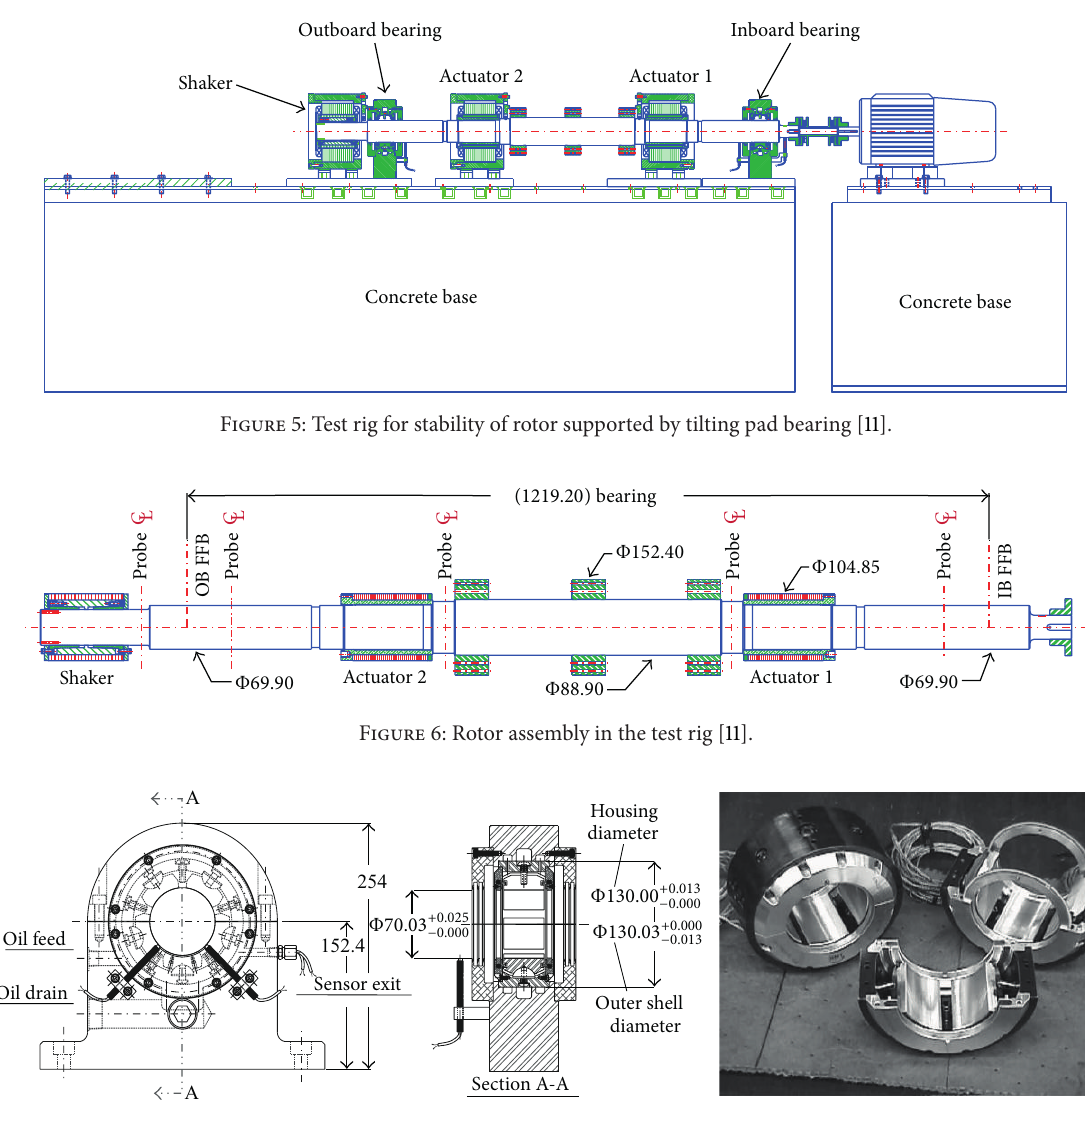
Figure 7: Drawing of bearing assembly and picture [11].